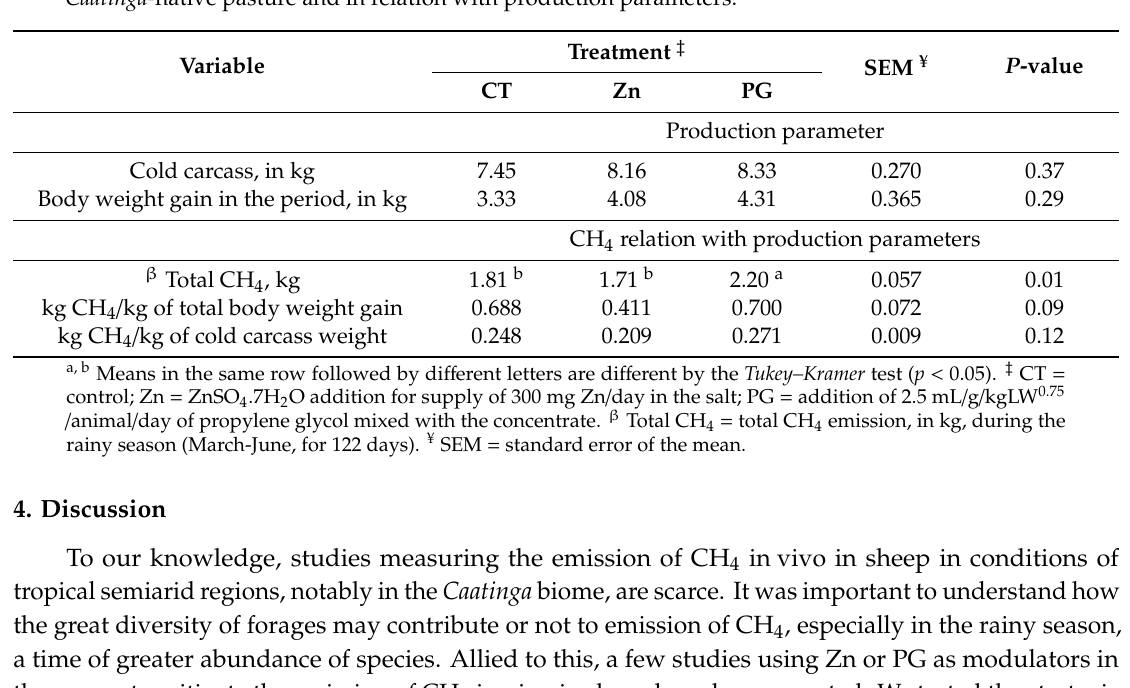
Table 4. E ff ect of zinc or propylene glycol supplementation on CH 4 emission from sheep in sheep on Caatinga -native pasture and in relation with production